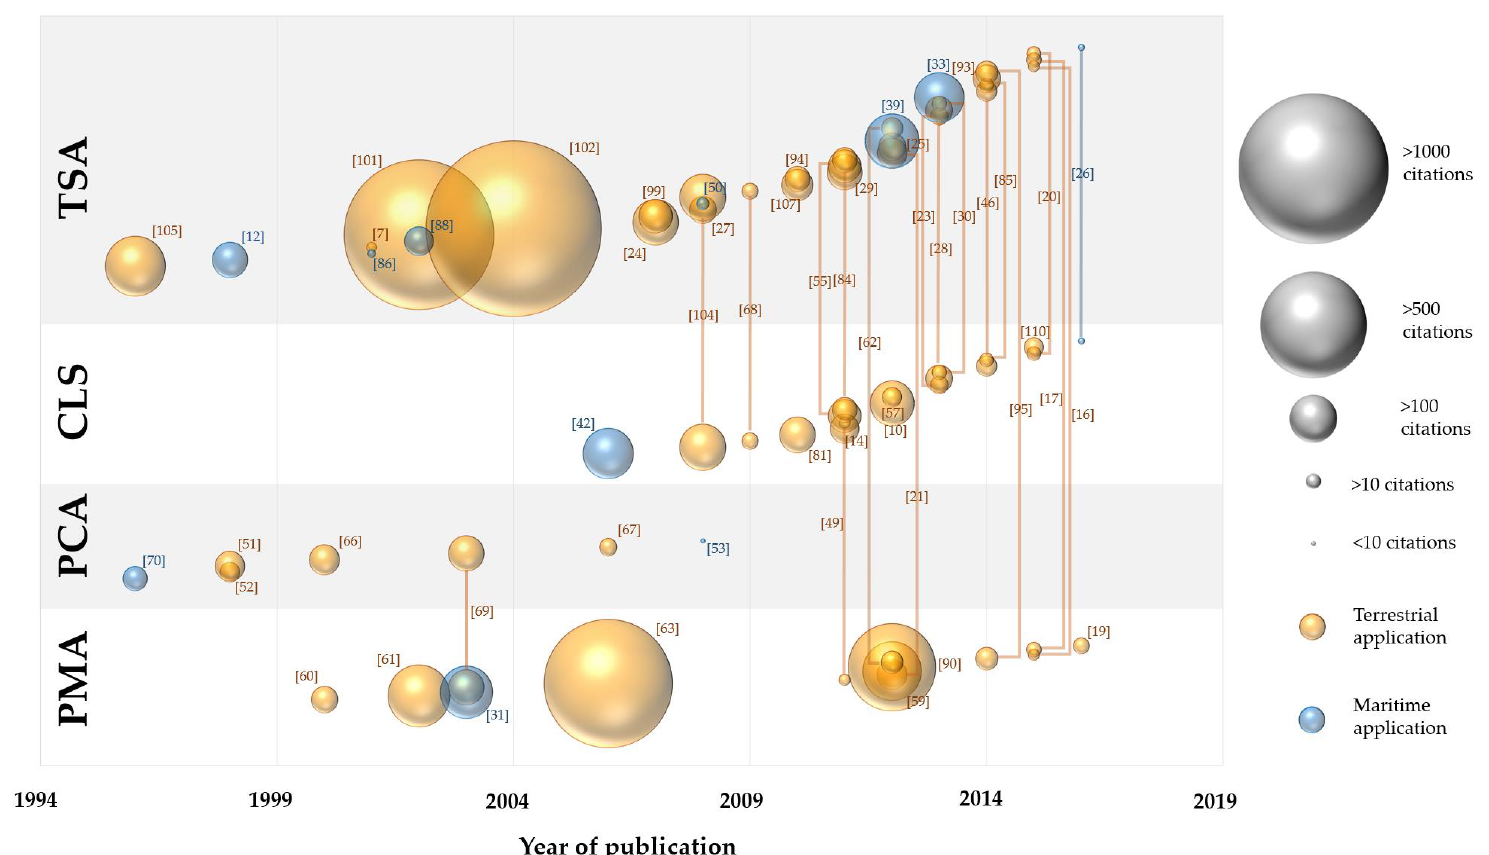
Figure 3. Methodological nature and grey-literature impact of hypertemporal papers reviewed in this article. Peer-reviewed articles and book chapters which implemented a methodology on a hypertemporal dataset (as defined here), have been classified on the basis of the outlined four primary approaches, and whether they were focused on a marine or terrestrial application. The bubble area infers the grey-literature impact, which was determined by recording the number of Google scholar citations associated with each publication on the 2 September 2019. Studies which deployed composite methodologies are indicated by linking lines between the component methodologies. Bracketed numbers link to the reference list of this review, to aid the reader identify the specific publication of interest to them.